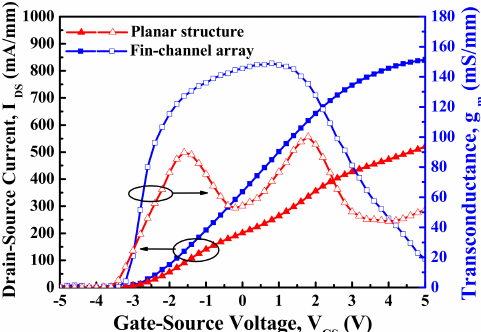
Figure 3. Drain–source current − gate–source voltage characteristics and extrinsic transconductance/gate– source voltage characteristics of double-channel MOSHEMTs operating at drain–source voltage of 10 V.